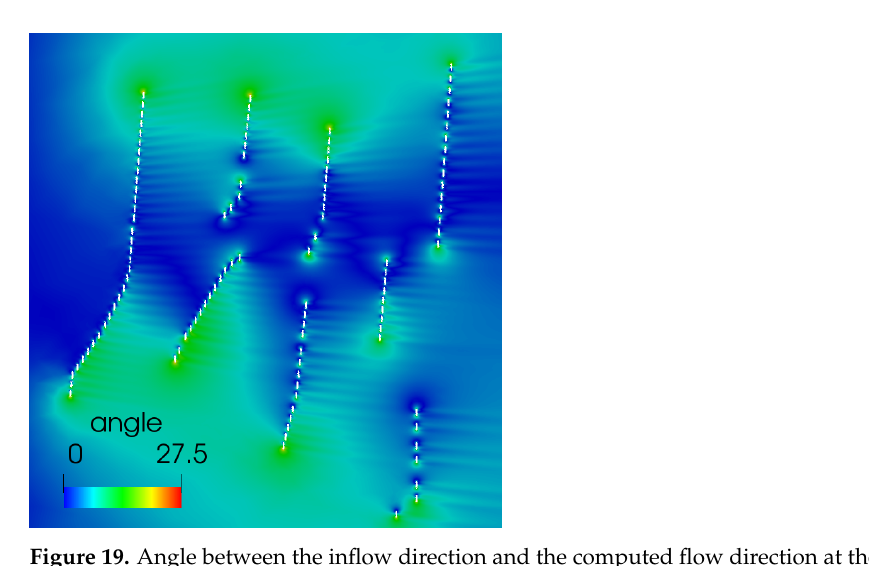
Figure 18. Actuator disc realignment process on the Sisante wind farm (115 turbines): ( a ) initial configuration and ( b ) final realigned configuration. The mesh is colored with respect to the wind speedup, and streamlines are also displayed.